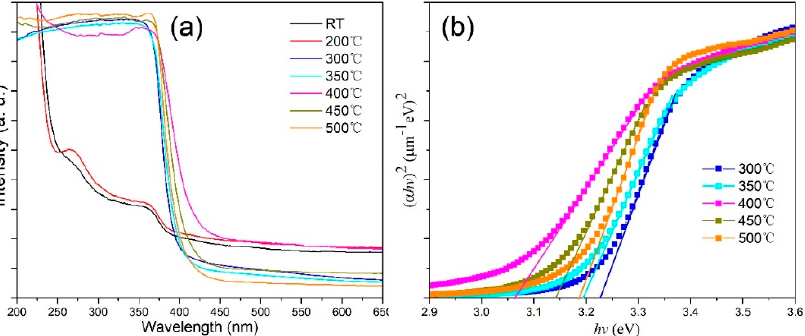
Figure 6. ( a ) UV-visible absorption spectra and ( b ) plots of ( α hv ) 2 vs. hv for the hierarchical ZnO microspheres prepared at different annealing temperatures.